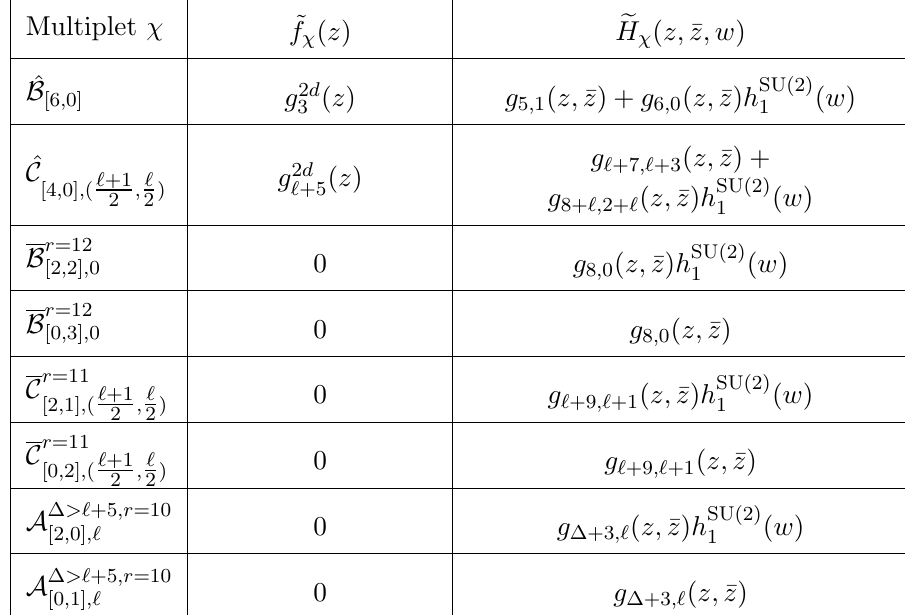
, C r =11 and [2 ; 0] ;‘ [0 ; 2] ; ( ‘ +1 2 ; ‘ 2)